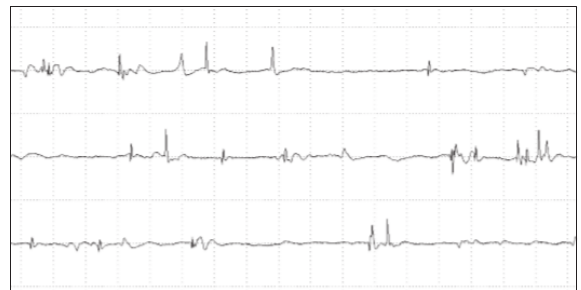
Figure 2: Needle electromyography of the biceps brachii mus- cle. Polyphasic, short duration, and low-amplitude patterns were observed during voluntary contraction.